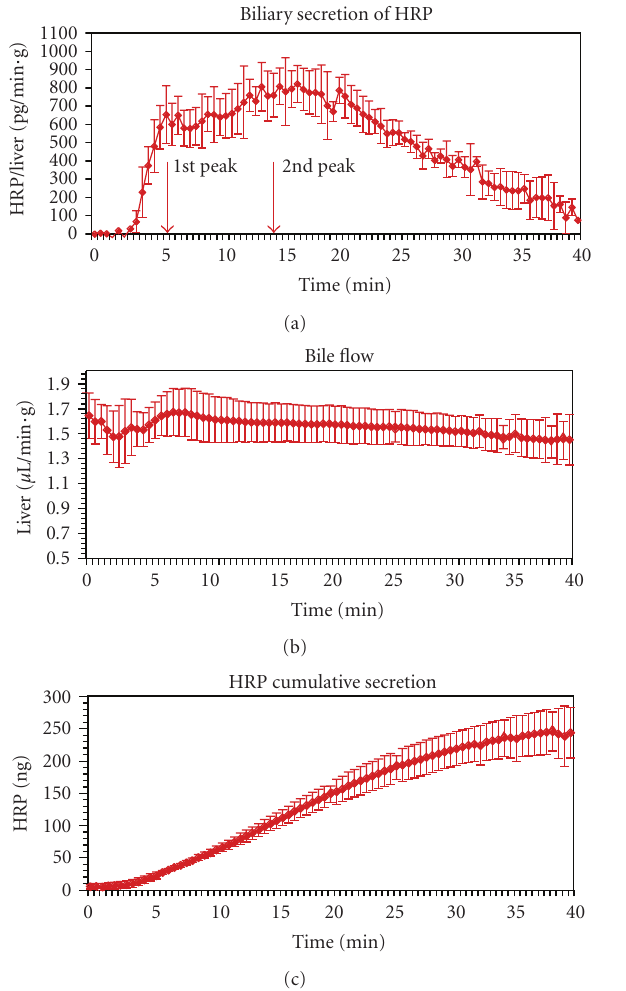
Figure 3: E ff ect of mannan on biliary HRP secretion. Livers were isolated and following 30 minutes perfusion, HRP (0,8mg/mL) plus 1.6mg/mL mannan was administered in the perfusion medium (KHB) for 1 minute at 37 ◦ C (time 0) followed by single-pass perfusion with marker-free KHB at 37 ◦ C for 40 minutes. The amount of HRP in single bile drops was determined and the secretion rate was calculated (a) based on the bile flow (b). Data shown are the mean ± SD of four perfusions. (c) The total amount of HRP (cummulative HRP secretion) secreted into bile as a function of the perfusion time is